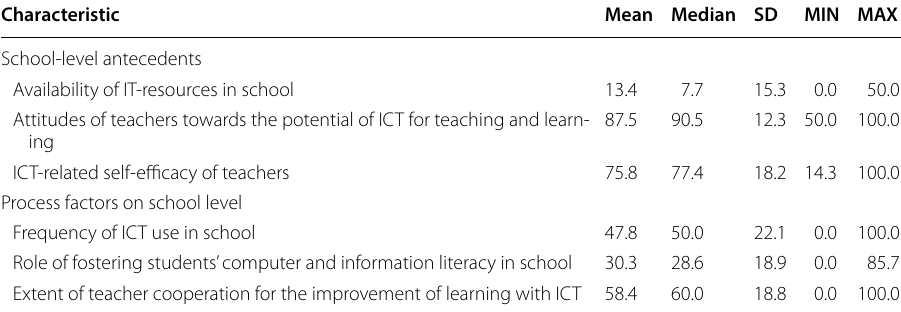
Extent of teacher cooperation for the improvement of learning with ICT